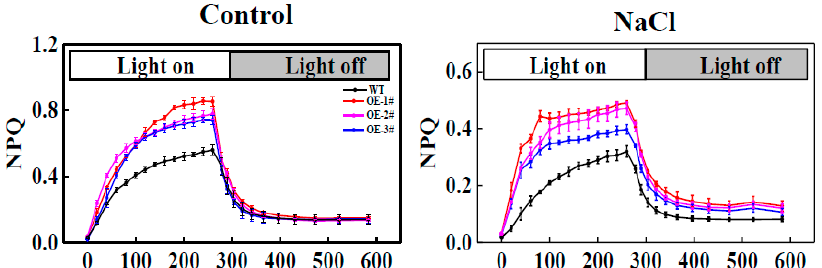
Figure 8. Nonphotochemical quenching (NPQ) induction and relaxation kinetics of WT and CsTGase OE plants under salt stress.